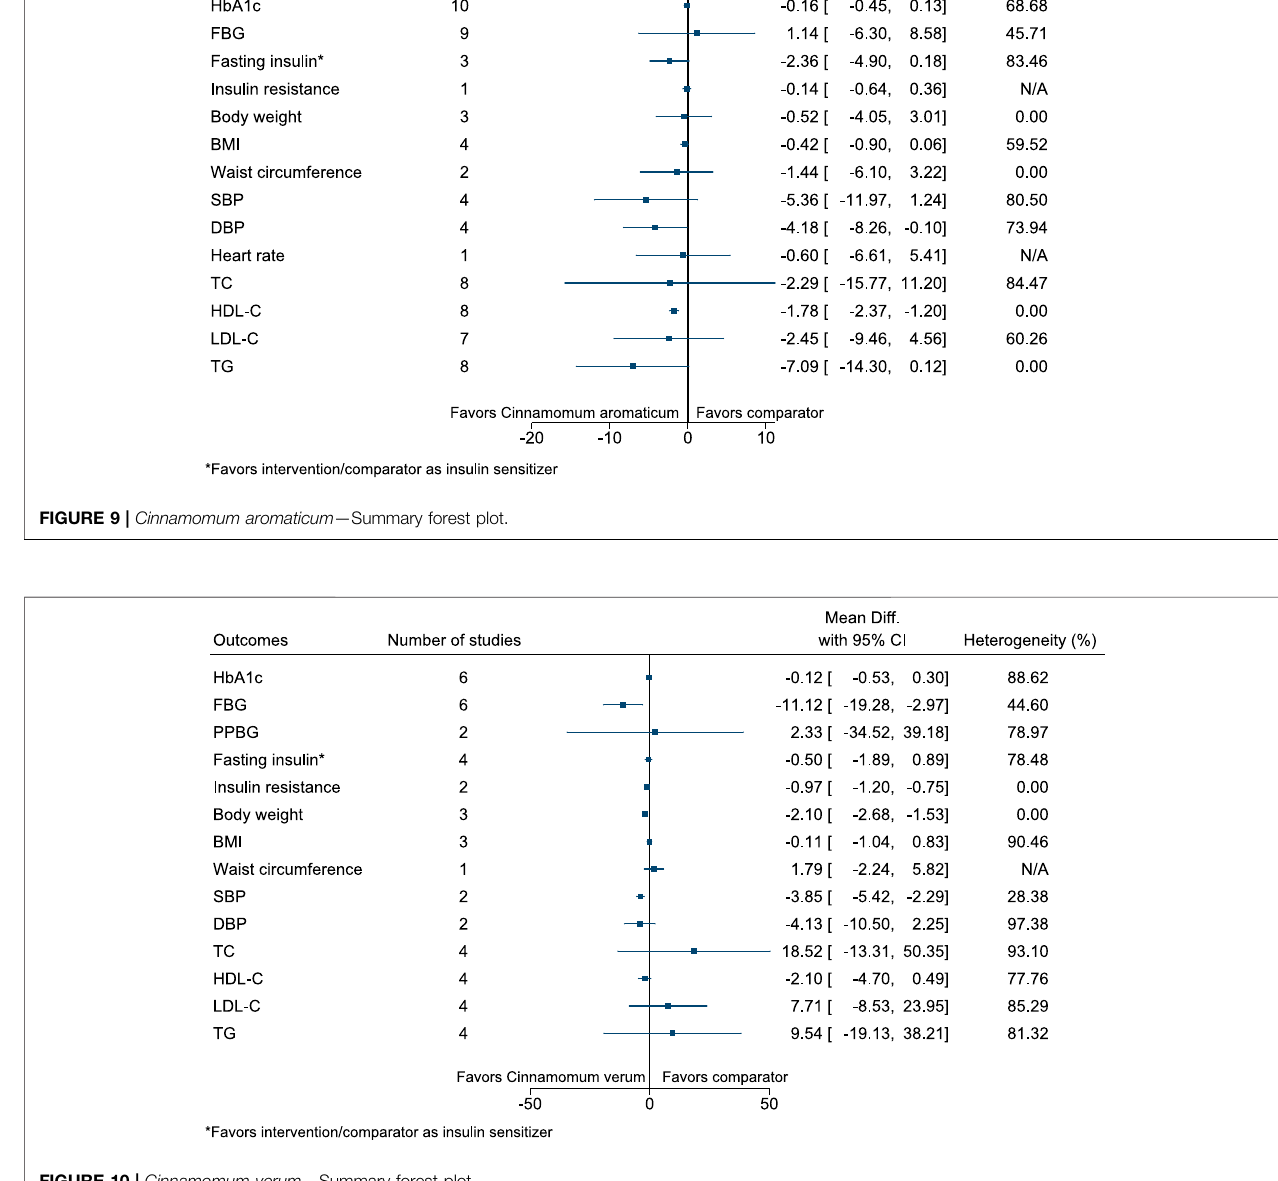
Frontiers in Pharmacology |